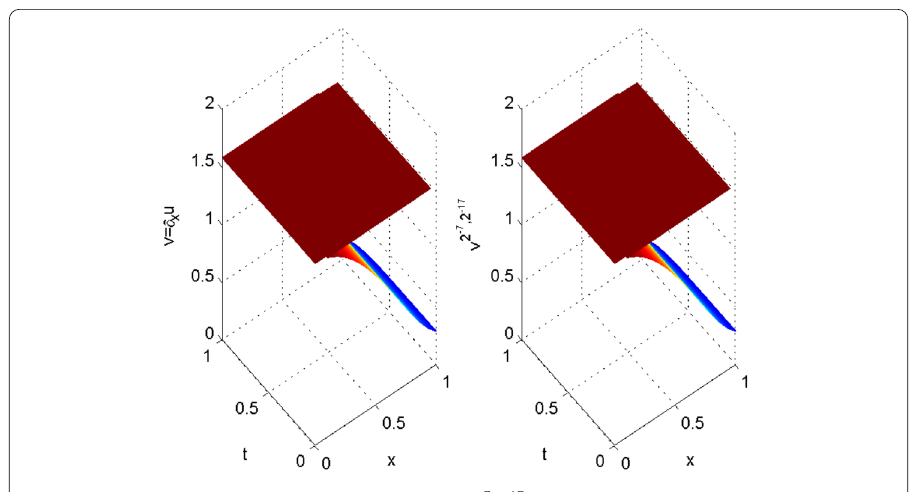
Figure 8 The exact solution ∂ x u and the grid function v 2–7,2–17 for h = 2 –7 , τ = 2 –17 of Example 2